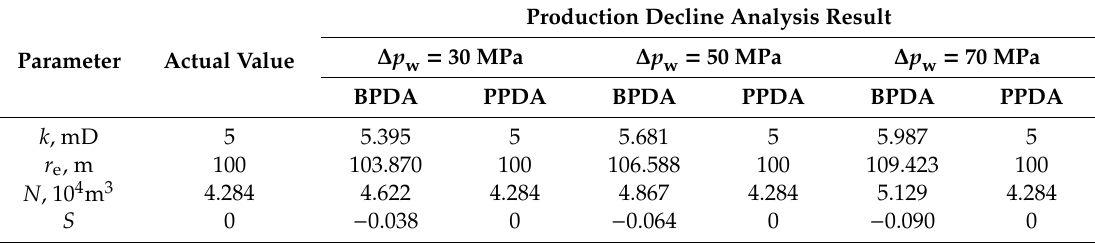
Parameter Actual Value